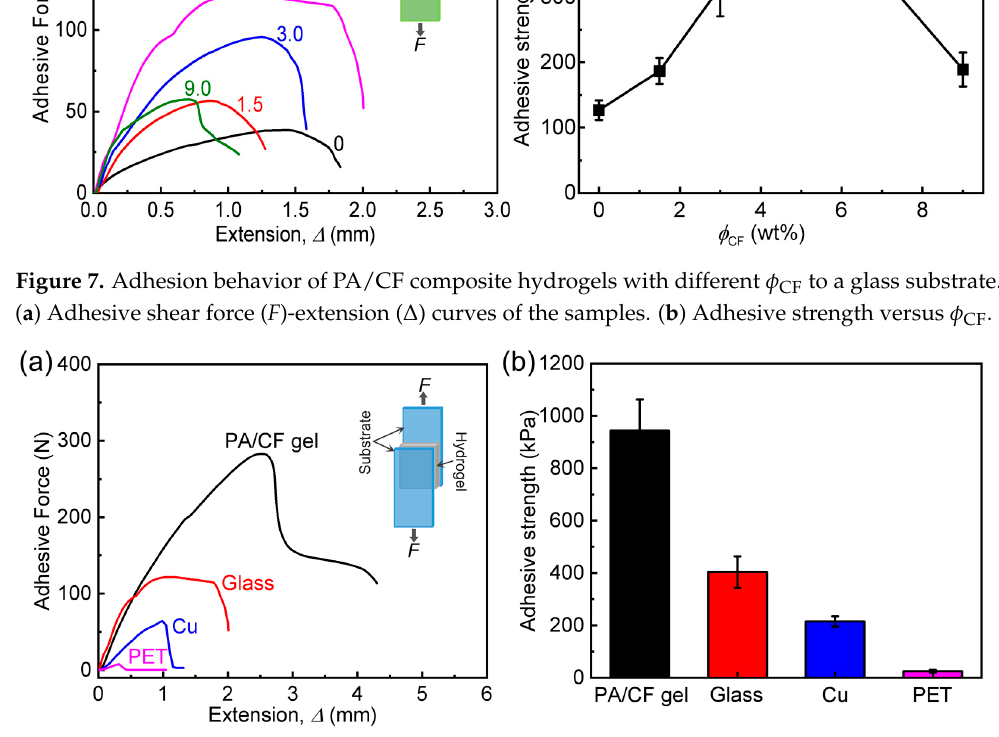
Figure 8. Lap-shear tests of PA/CF composite hydrogels on diverse substrates. These substrates include glass, metal (i.e., Cu), and plastic (i.e., PET). Self-lap-shear adhesion data of PA/CF gel is also included for comparison. ϕ CF = 6.0 wt%. ( a ) Adhesive force ( F )-extension ( Δ ) curves of the samples on different substrates. ( b ) Calculated adhesive strength of the samples on different substrates based on the tests.